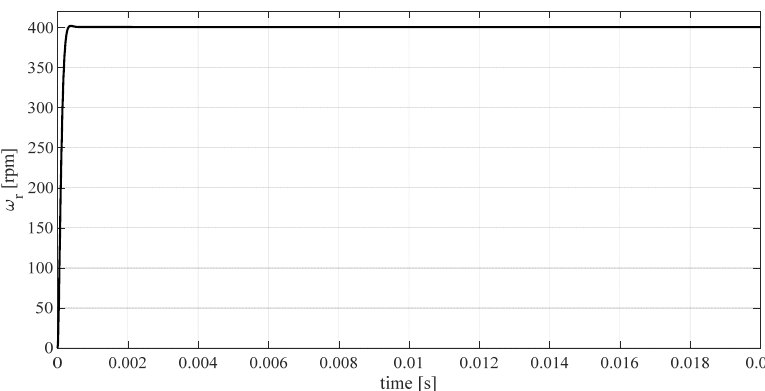
Figure 4. First iteration of the MFO algorithm to calculate the initial parameters of the neurocontroller.